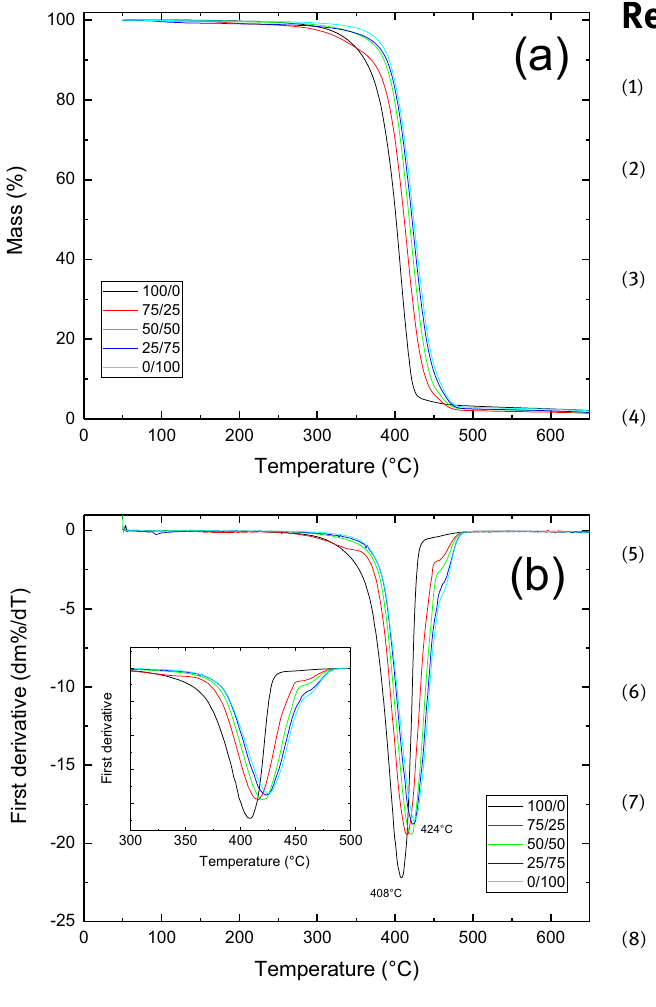
Figure 8: ( a ) TGA and ( b ) DTGA curves of MW - assisted ROP - synthesized copolyesters CL –